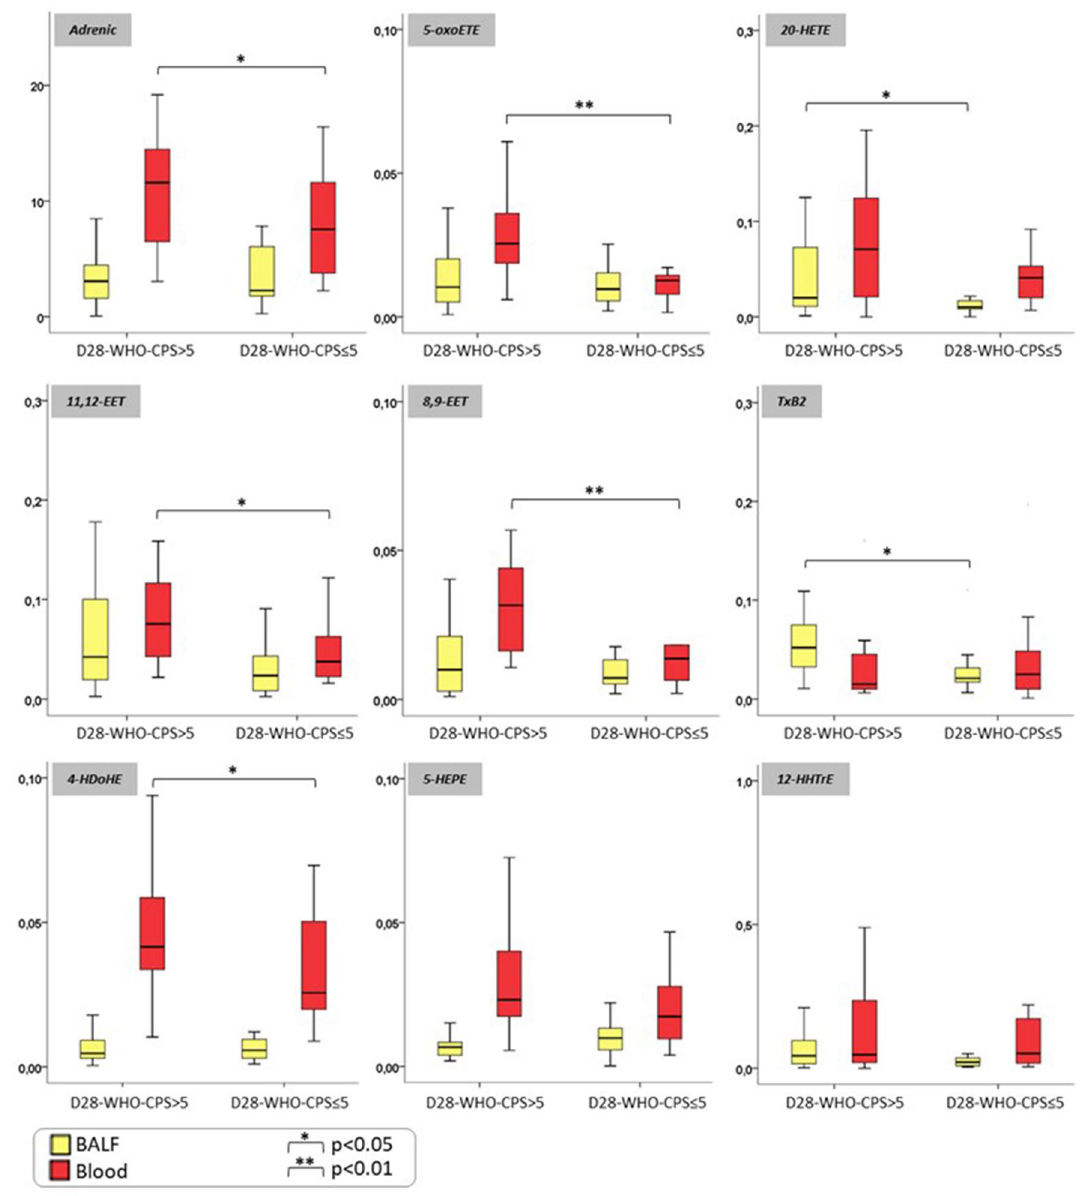
Figure 5. Eicosanoid profiling of blood and bronchoalveolar lavage fluid of critically ill COVID-19 patients, according to the 28-day WHO-CPS. Data are presented as box and whiskers plots (N = 16–26 per group). Patients were grouped according to the World Health Organization 10-point Clinical Progression Scale (WHO- CPS) at 28-day. A score value higher than 5 (D28-WHO-CPS > 5) defined a poor 28-day outcome, whereas a score value equal or lower than 5 (D28-WHO-CPS ≤ 5) defined a good 28-day outcome. Groups were compared using the non-parametric Mann–Whitney test for bronchoalveolar lavage fluid (BALF) concentrations and blood concentrations of each eicosanoid. All the concentrations are expressed in